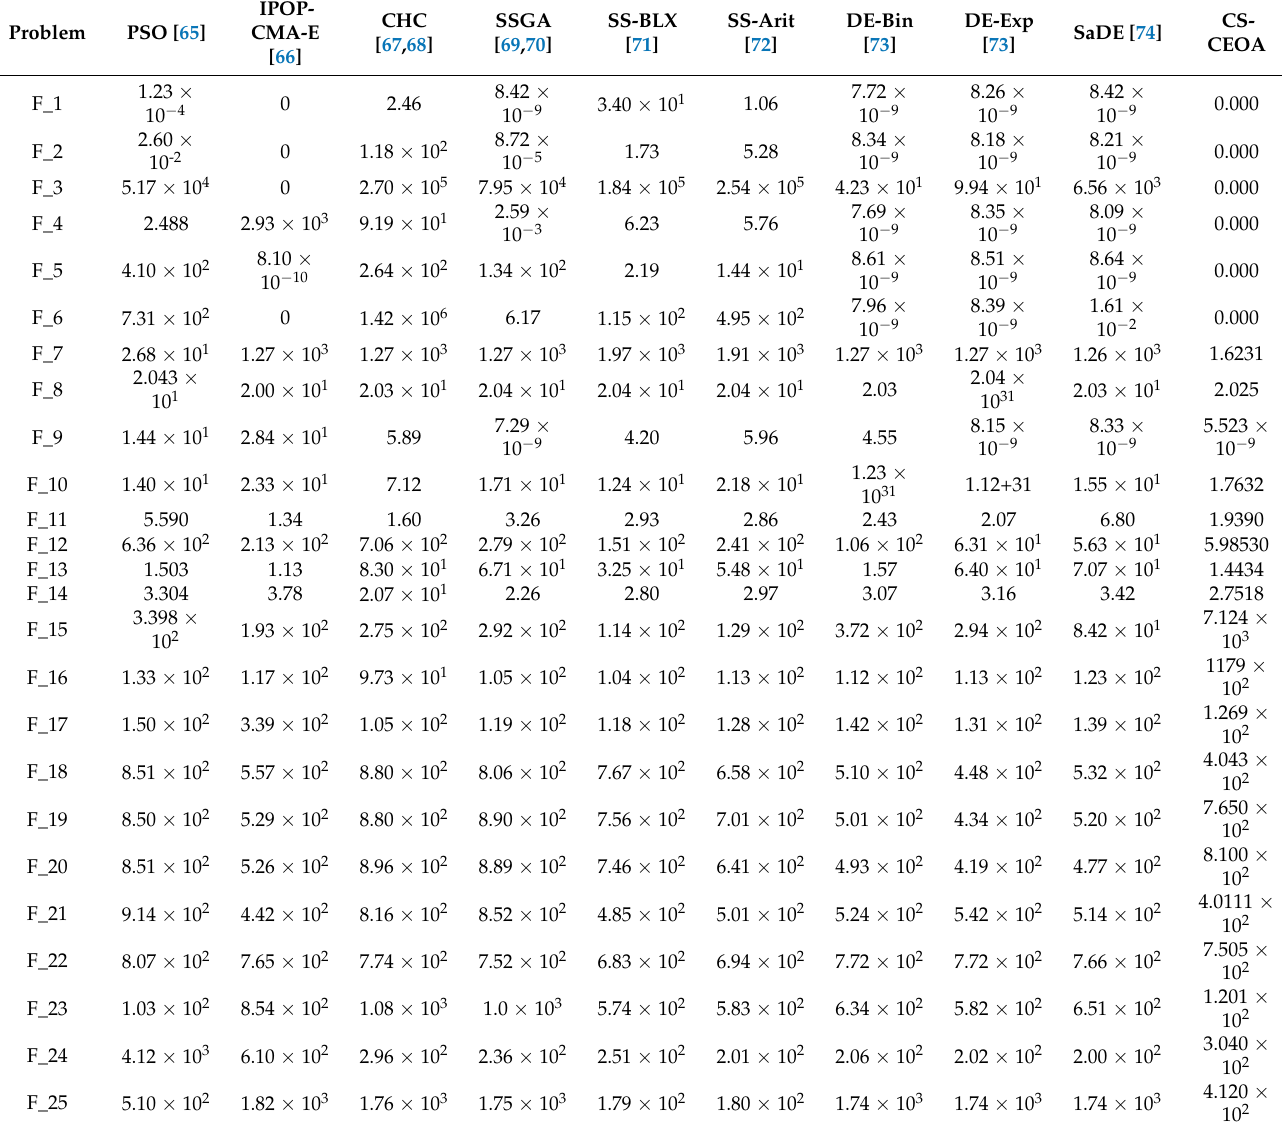
Table 5. Average error of CEC’05 obtained by CS-CEOA versus other optimization